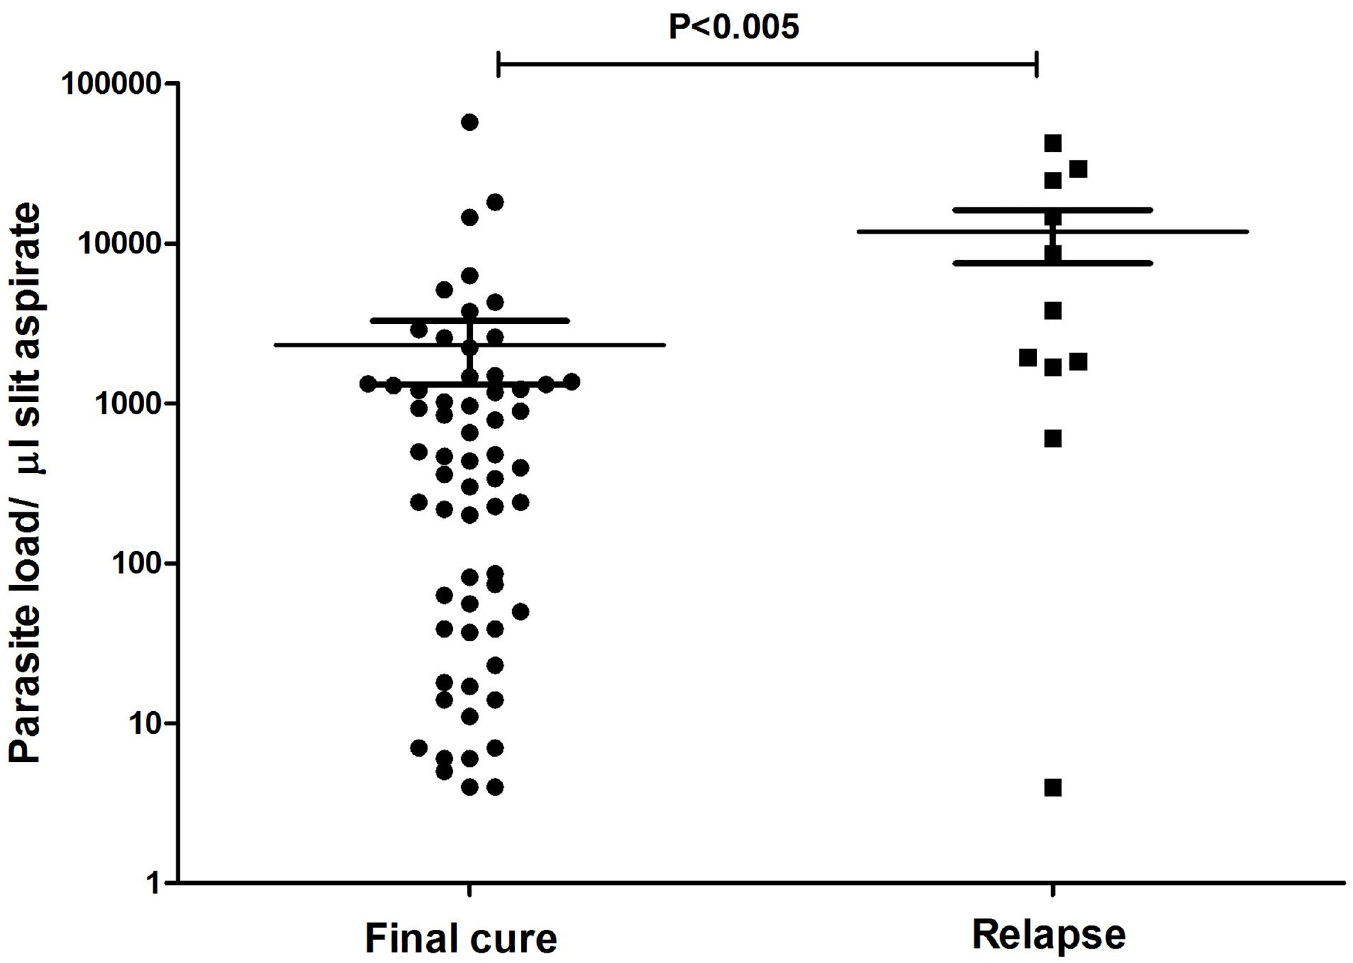
Fig 3. Scatter plot showing parasite load at the pre-treatment stage in the cases that eventually relapsed vs those that remained cured. Parasite load was determined by Q-PCR in slit aspirate sample at the time of diagnosis of PKDL and expressed as the number of Leishmania parasite/ μ l slit aspirate. P value was calculated using Mann-Whitney test. Horizontal bars indicate mean ±